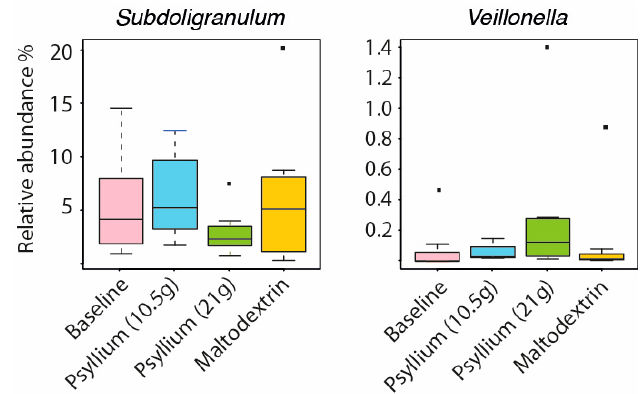
Figure 2. Microbial changes introduced by the psyllium supplementation to the intestinal microbiota of healthy adults.